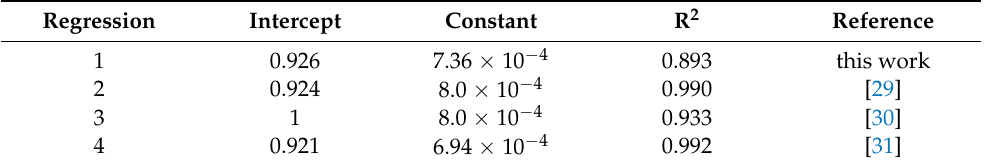
Figure 4. Relation between measured CT numbers obtained with Average Intensity Projection (AIP) on manually selected volumes (see Section 2.2) and calculated bulk density of sediment (crosses and black regression line no. 1). Lines 2–4 correspond to CT number calibration obtained by various authors using density standards (cf. Table 2). Table 2. Statistics of regressions shown in Figure 4. Regressions 2–4 are obtained using various homogeneous and heterogeneous density standards, such as water, bentonites, wood and rocks. All CT numbers are obtained using X-ray energy of 120 keV.